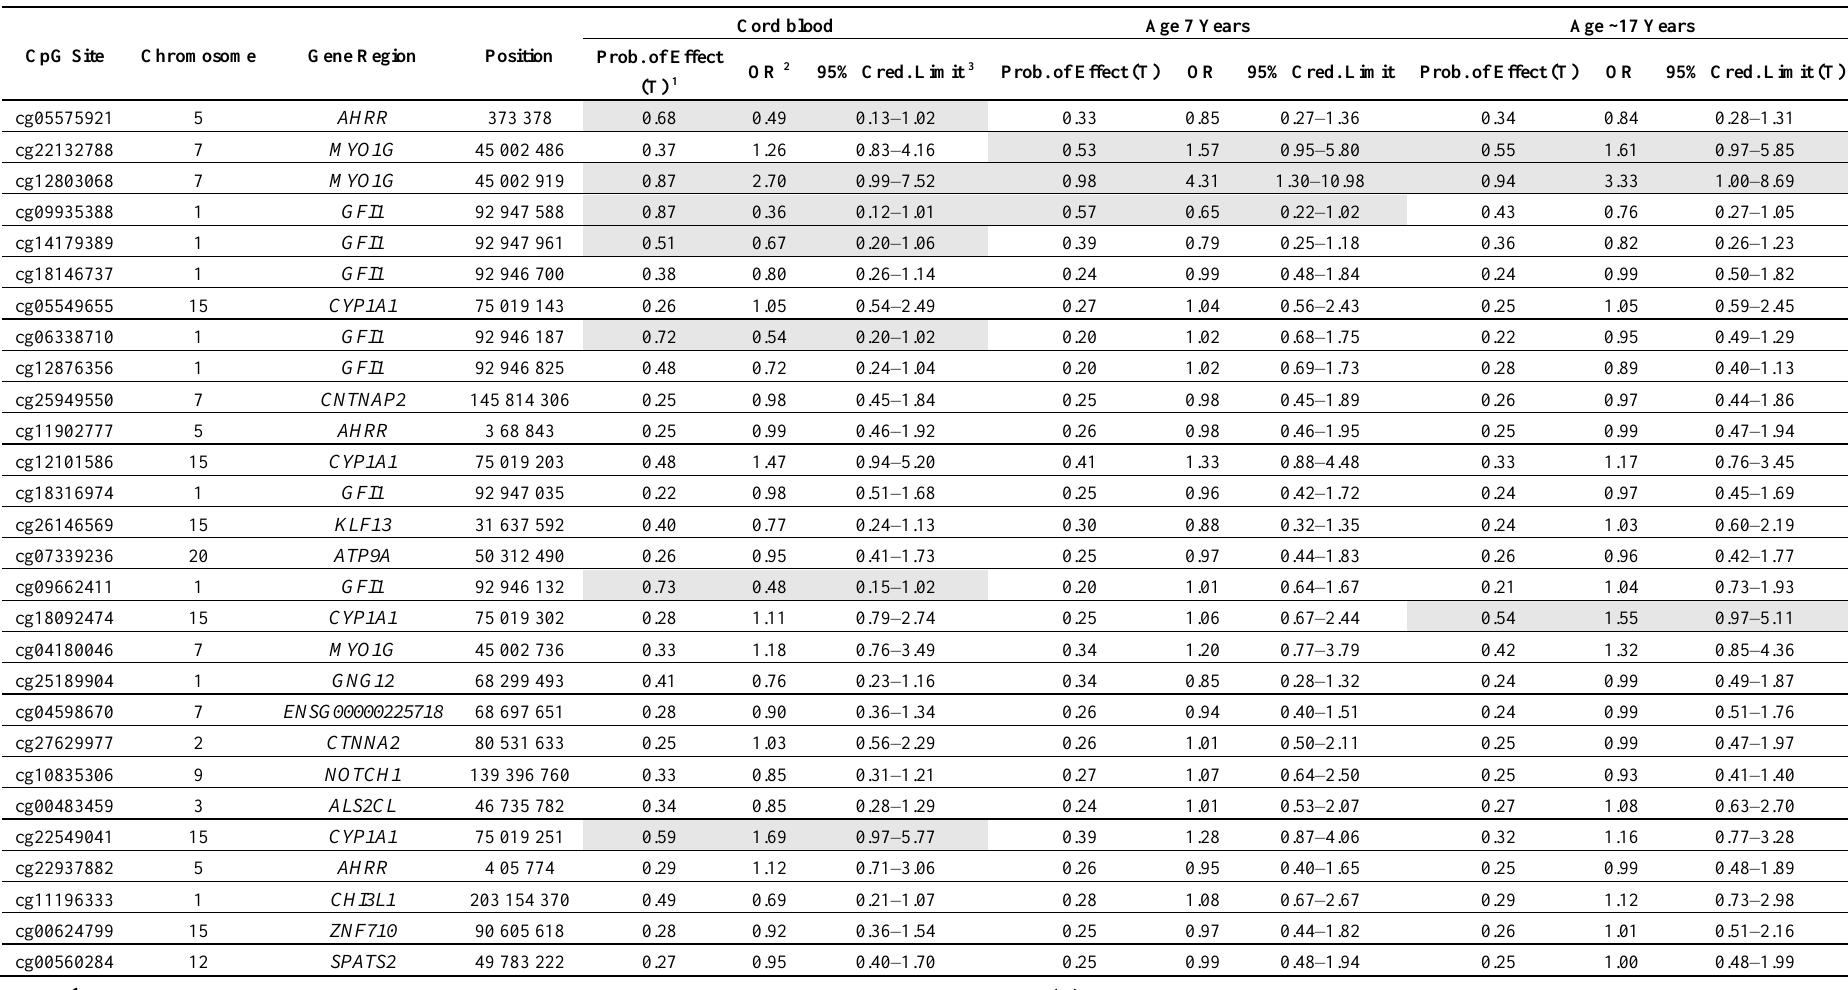
Table 2. Results of the hierarchical Bayesian mixture model in cord blood, at age 7 and age 17 years for imputed dataset